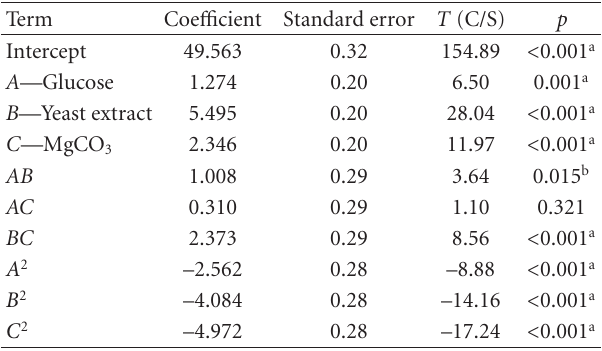
Figure 2: Response surface curve for the succinic acid production by Actinobacillus succinogenes ATCC 55618 showing the combination e ff ects of (a) glucose and yeast extract, (b) yeast extract and MgCO 3 , and (c) glucose and MgCO 3 . Other factors are constant at zero levels. Table 5: Regression coe ffi cients and their significance for response surface